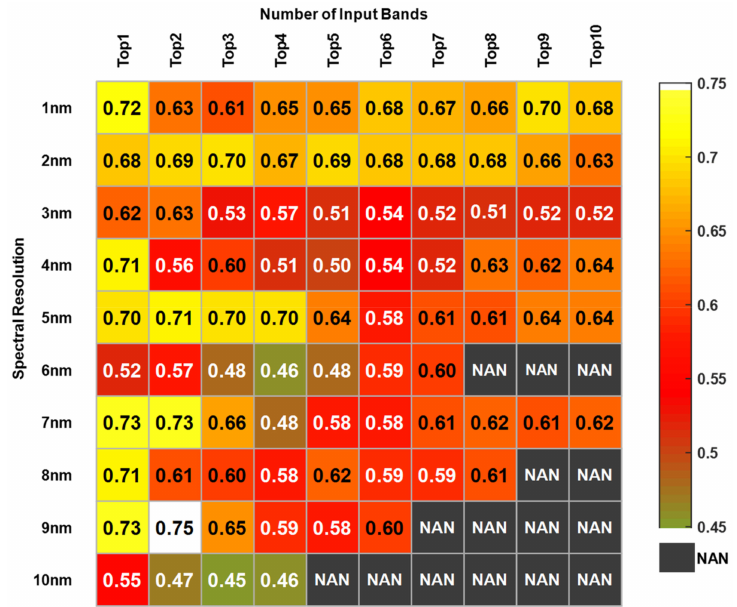
Figure 4. Diagnostic accuracies of Pb pollution diagnosing for band combination selecting.